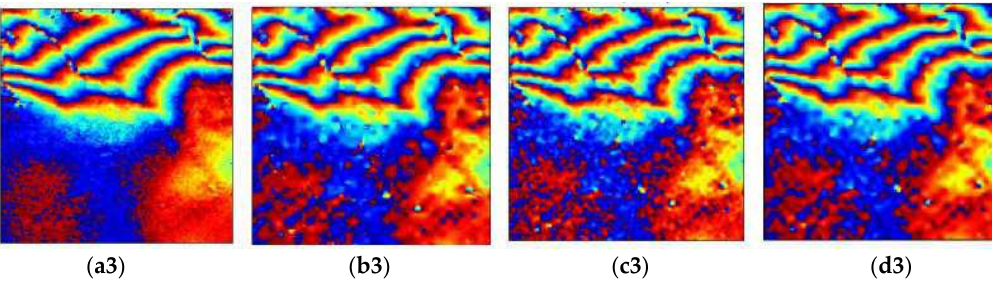
Figure 11. Interferogram over Hong Kong filtered by ( a1 ) the Goldstein filter; ( b1 ) the wavelet filter; and ( c1 ) Lee filter; ( d1 ) the proposed filter; ( a2 – d2 ) Close-up of the results of area A in Figure 10; ( a3 – d3 ) Close-up of results of area B in Figure 10. (Unit: rad).